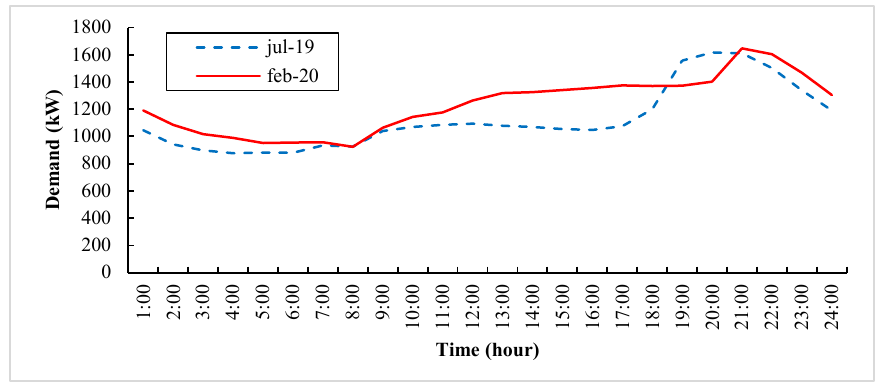
Figure 1. Profile of average demand July 2019 (Chilean winter) and February 2020 (Chilean summer).